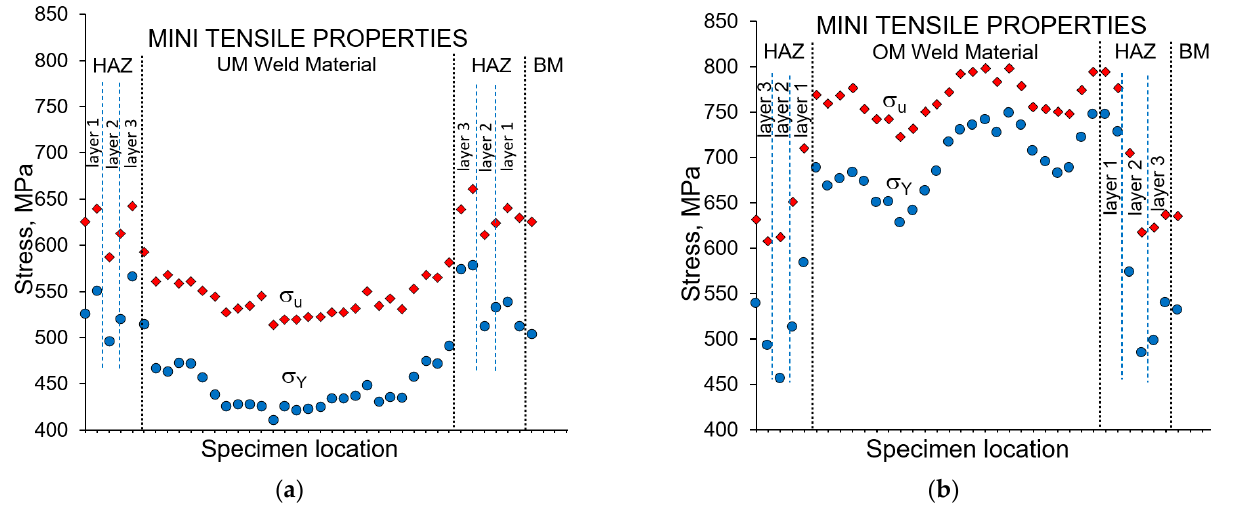
Figure 3. Results of tensile testing of both welded metals from mini tensile specimens: ( a ) under-match weld joint; ( b ) over-match weld joint.